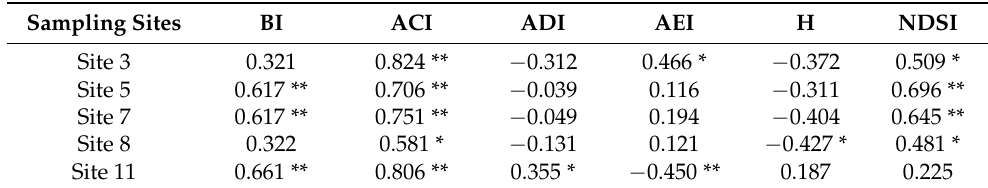
Table 5. The Spearman rank correlation coefficients between acoustic indices and bird species richness at different sites after geophony elements